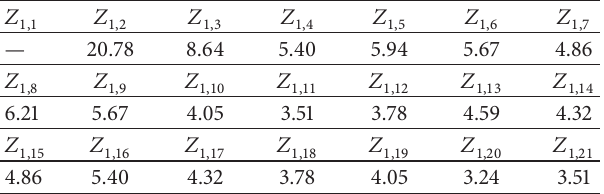
Figure 5: Reflection and transmission coefficient of two-layer rod PBG.